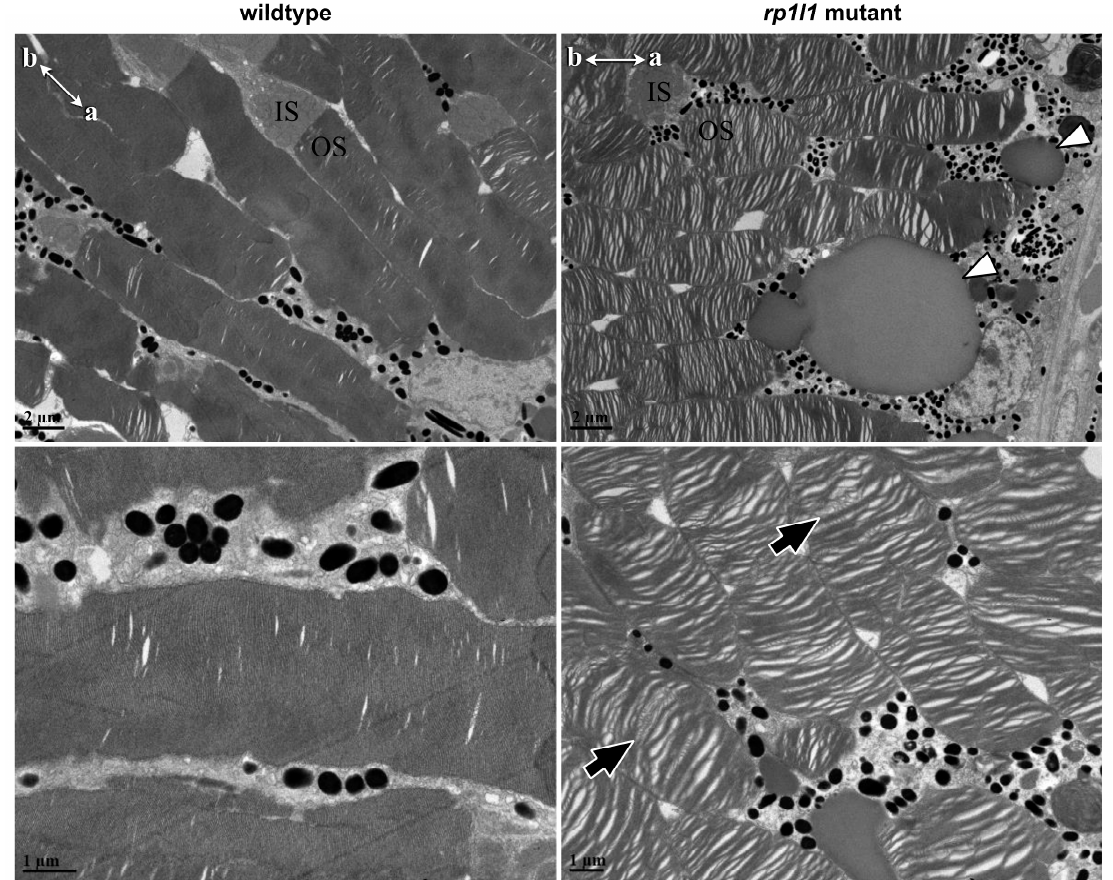
Figure 7. rp1l1 mutant zebrafish have disorganized photoreceptor outer segments and deposits between the photoreceptors and retinal pigment epithelium. Electron microscopy of 11-month-old mutant and wild-type photoreceptors. Mutant photoreceptors appear disorganized, with gaps between the discs, and discs wave or swirl in some outer segments (black arrows). Additionally, there appear to be deposits between the photoreceptor outer segments and retinal pigment epithelium (white arrowheads). IS = inner segment; OS = outer segment. Compasses in top-left corners show apical (a) and basal (b) photoreceptor orientations for the images.